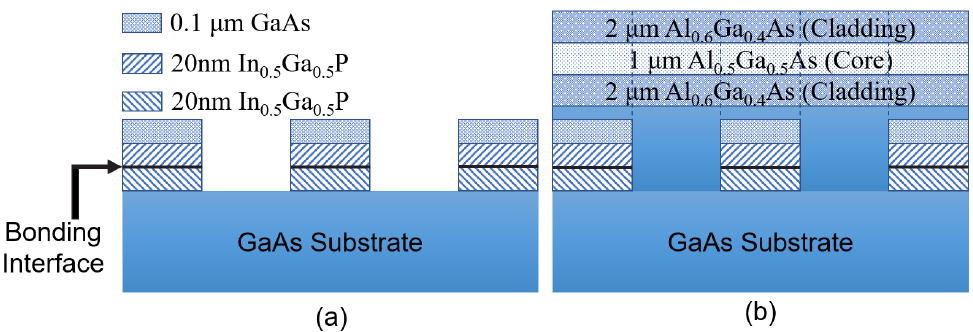
Figure 3. ( a ) Schematic showing a PDI template with varying crystal orientation at the bonding interface and ( b ) the ultimate heterostructure regrown on the patterned PDI template. Adapted from [30], with the permission of AIP Publishing.